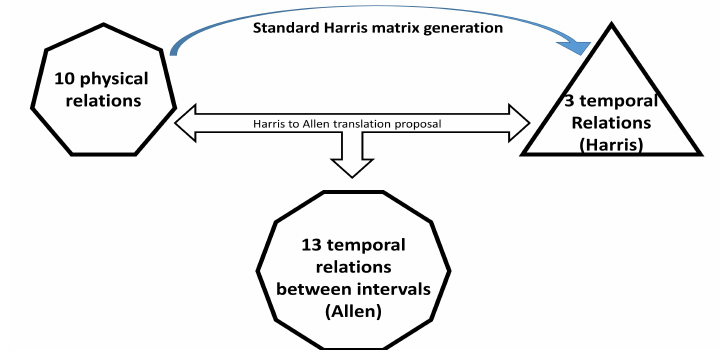
Figure 21. Harris to Allen proposal schema.